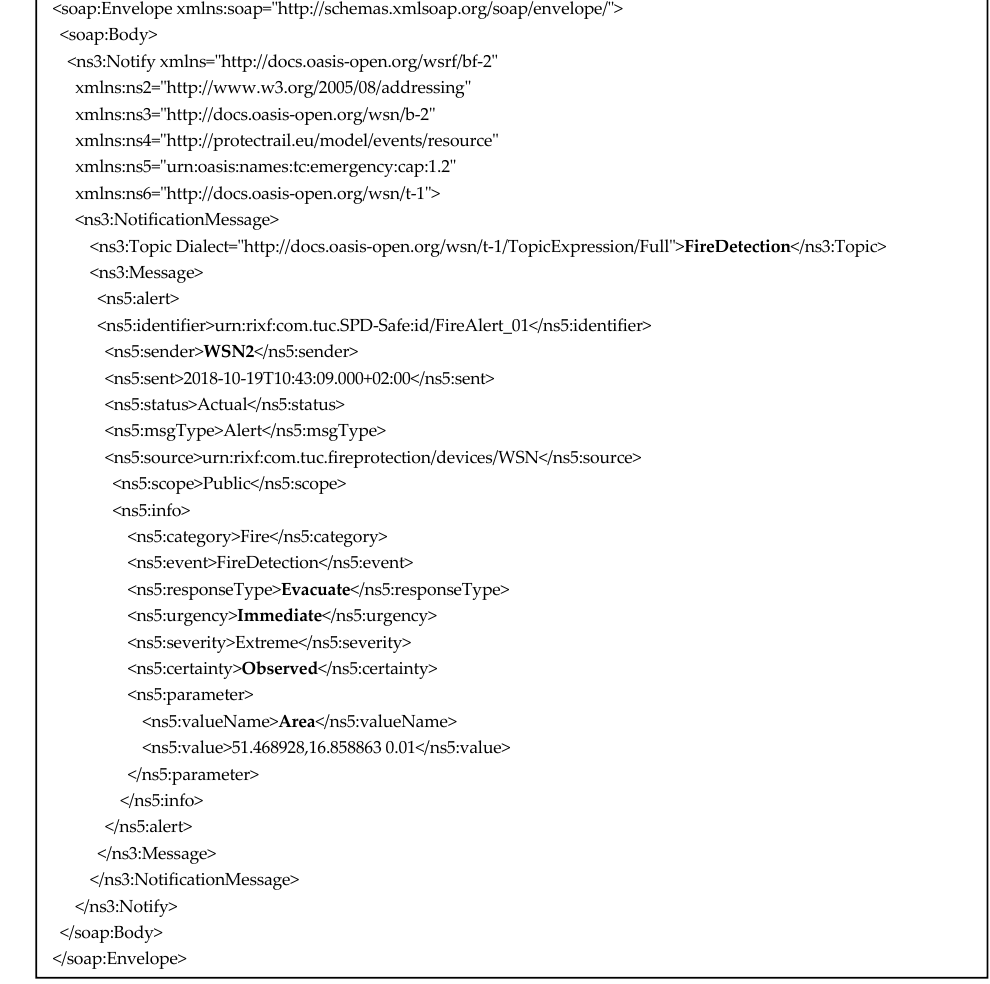
Figure A1. Simple Object Access Protocol (SOAP) message that contains the CAP alert for the fire alarm. The code shown in Figure A2 summarizes the main processing flow and the emergency response rules that perform the described actions (for more information regarding EC, please refer to Mueller [73]).